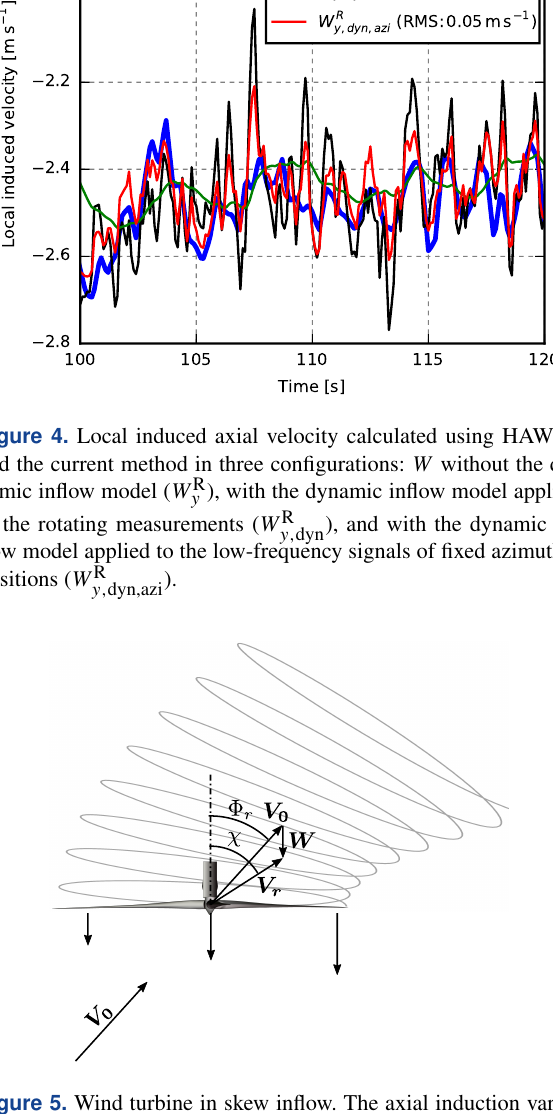
Figure 5. Wind turbine in skew inflow. The axial induction varies due to different wake vorticity concentration, and it is not directed exactly towards the